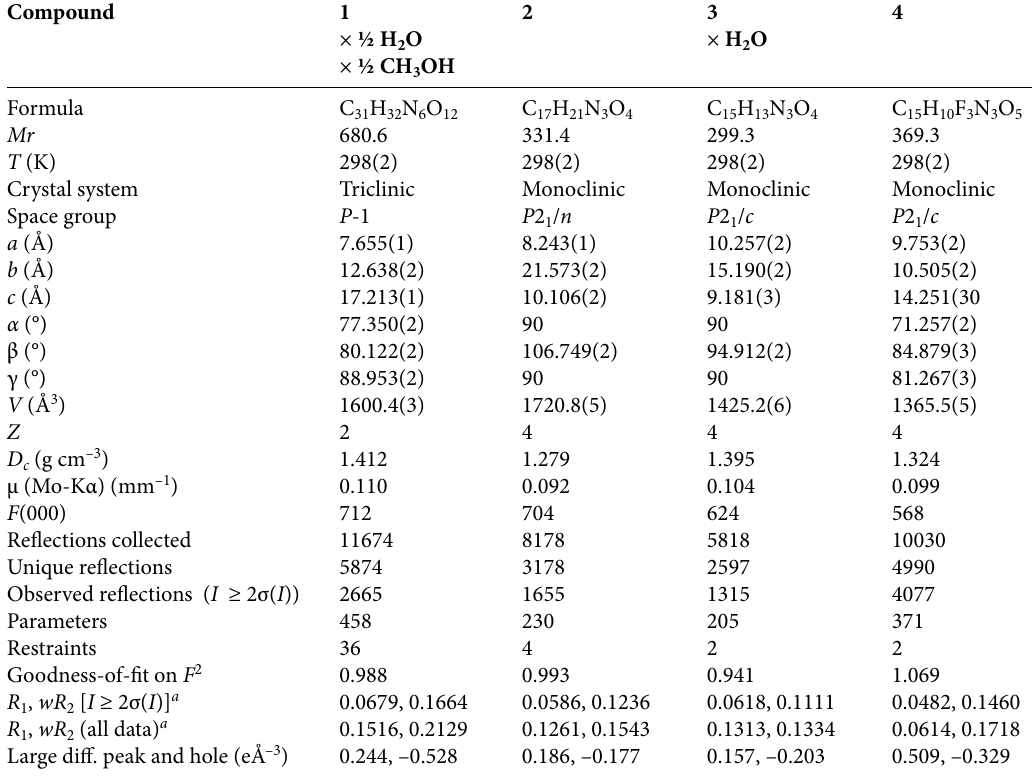
Table 1. Crystallographic and experimental data for the